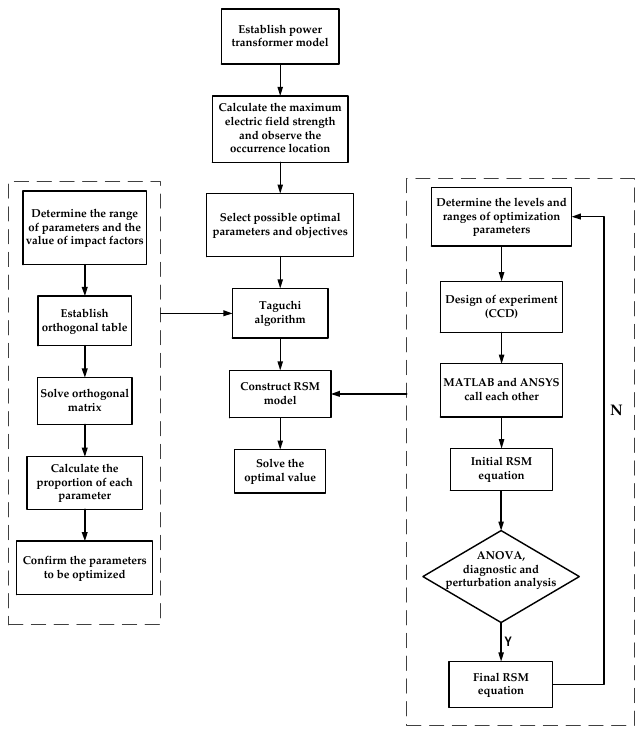
Figure 5. Flowchart of insulation structure optimization of power transformer based on RSM.